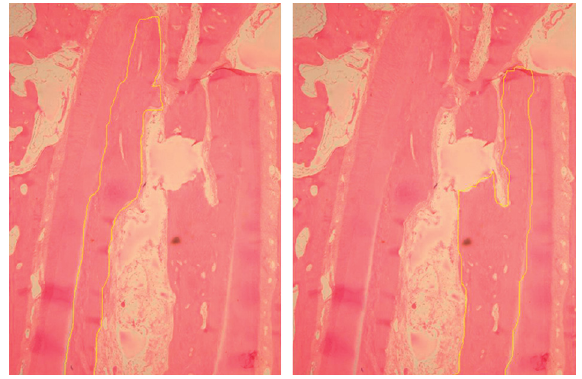
Figure 2. Photomicrograph of a specimen from the triple antibiotic paste group showing deposition of cementum-like mineralized tissue onto dentin (yellow lines). 20×